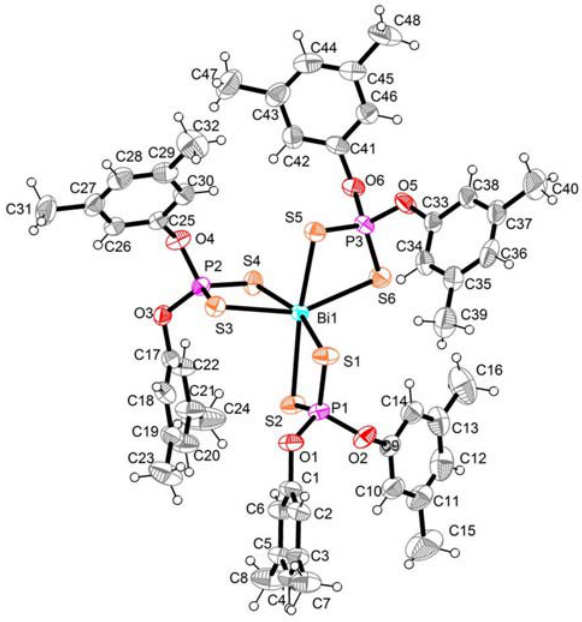
] ) C H O } PS Bi ( 4 ). 3 2 6 3 2 2 3